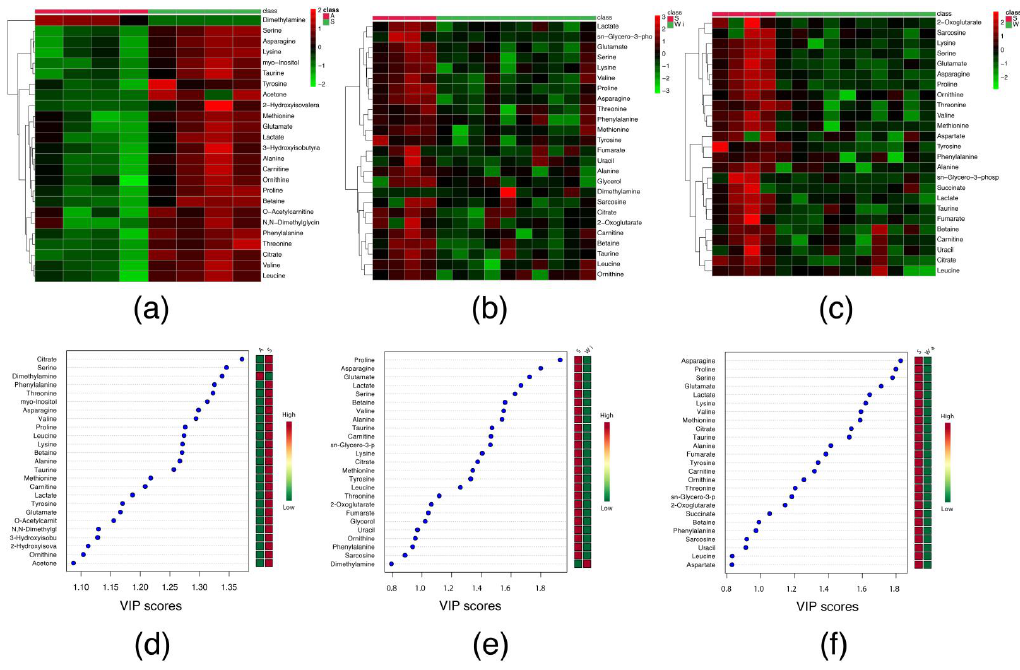
Figure 1. Heatmaps and Variable Importance in Projection scores of serum metabolic profile identified in adult, ageing and ageing Walker 256 tumour-bearing rats. ( a – c ) Heatmaps of comparison between S versus A; Wi versus S and Wa versus S, respectively; ( d – f ) Variable Importance in Projection (VIP) scores represents the comparison between S versus A; Wi versus S and Wa versus S, respectively. Legend: (A) control adult rat; (S) control ageing rat; (Wi) ageing tumour-bearing rat in intermediated stage; (Wa) ageing tumour-bearing rat in advanced stage. The red and green boxes indicate high and low abundance ratio, respectively, of the corresponding